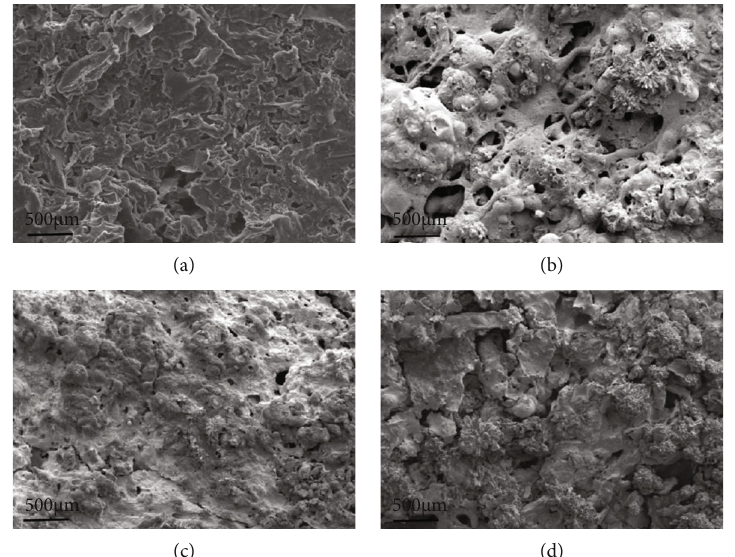
Figure 11: SEM images of the char residues of the PVA composite aerogels: (a) PVA/H 10APP-CS/H